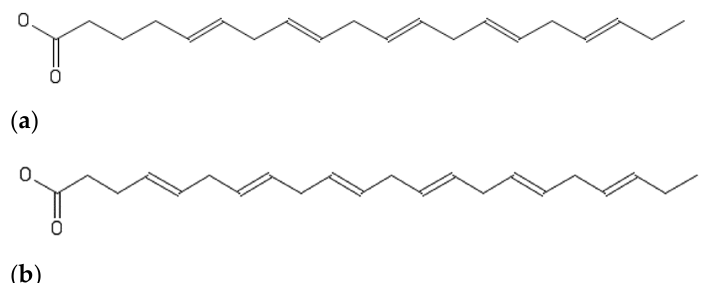
Figure 1. Chemical structures of some PUFAs produced by microalgae: ( a ) Chemical structure of EPA; ( b ) chemical structure of DHA. EPA; ( b ) chemical structure of